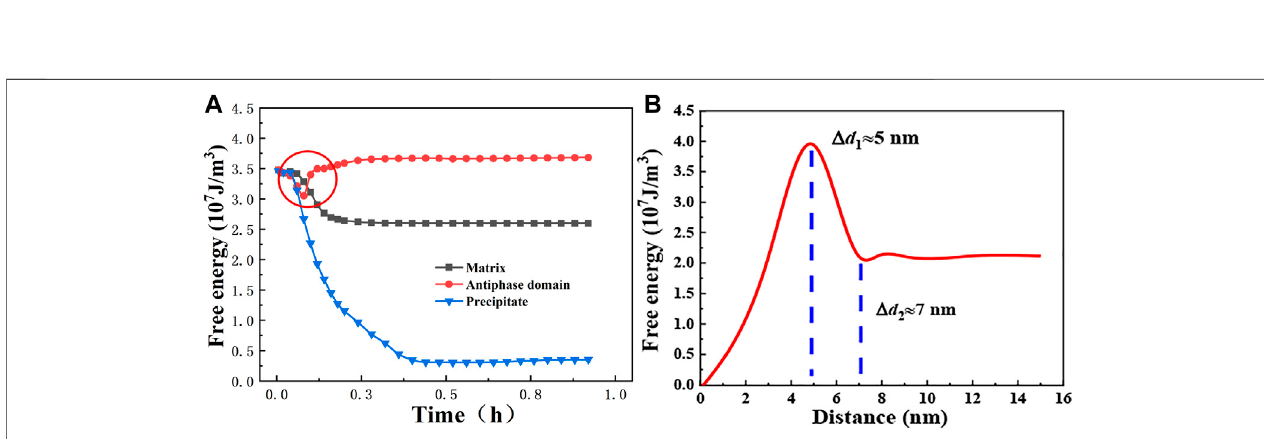
Figure 1D shows the mesoscopic microstructure of Co – 10Al – 10W at% alloy aged for 1 h at 1173 K, in which the white areas represent the γ ʹ phases with equilibrium composition fi eld of W.